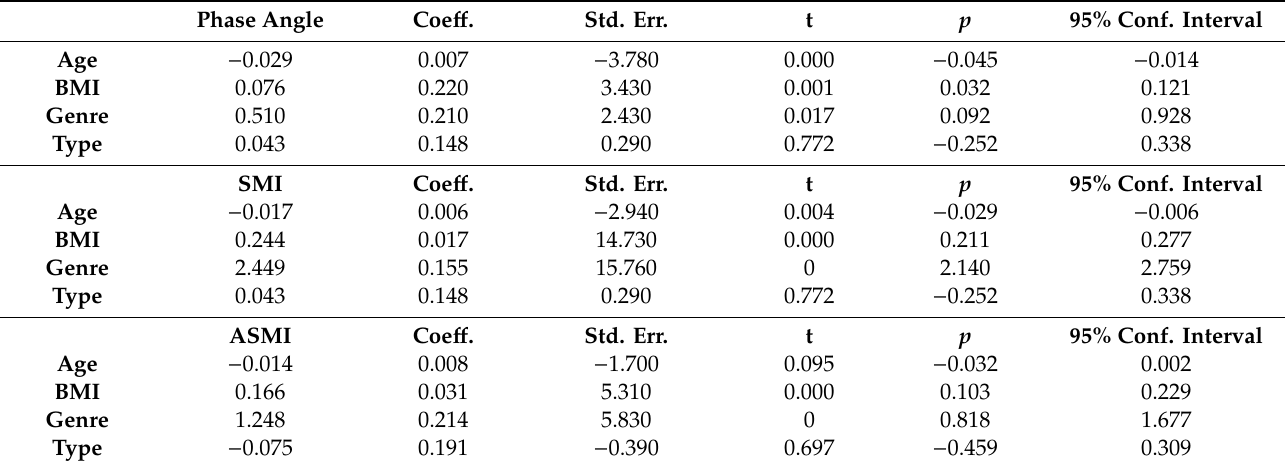
Abbreviations. BMI: Body Mass